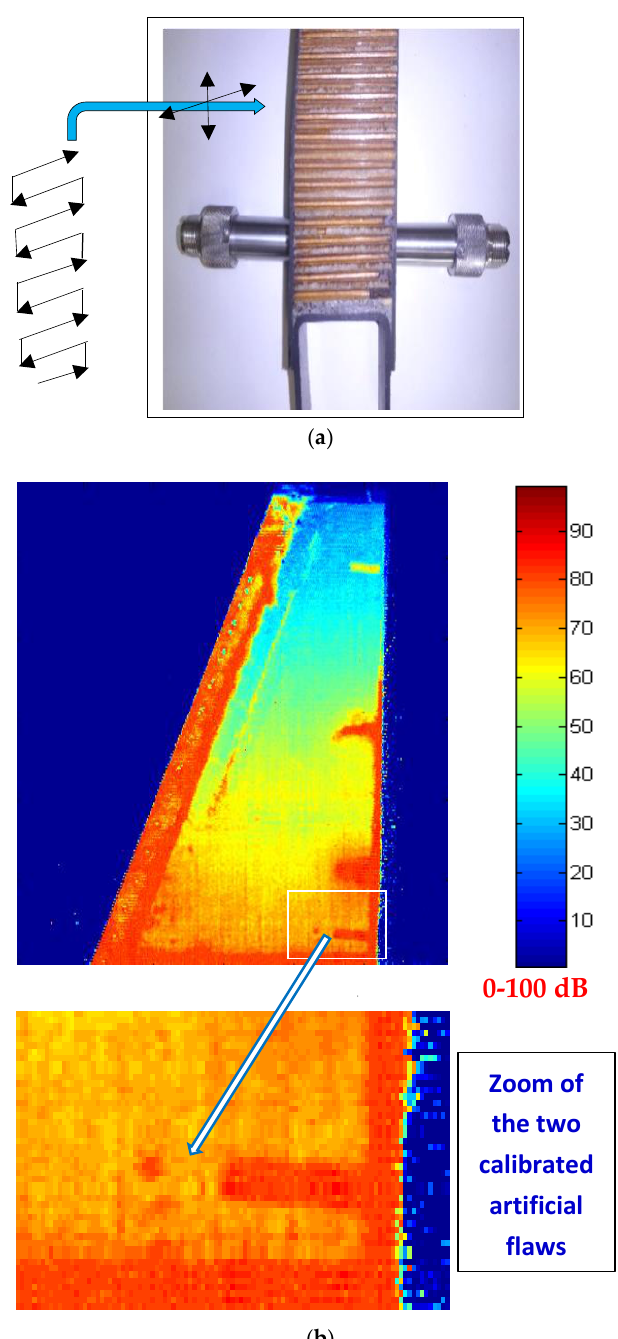
Figure 14. Application of our tuned capacitive driver for NDE of a portion of landing flap in Boeing- 777 wing. ( a ) Laboratory-scale mock-up showing how ultrasonic C-Scan imaging was made, with two T–T transducers (here, the real piece of Figure 13 and water jets are not shown). ( b ) The very sharp imaging that was achieved, overpassing losses (into the inspected flap and water jets) of up to 150